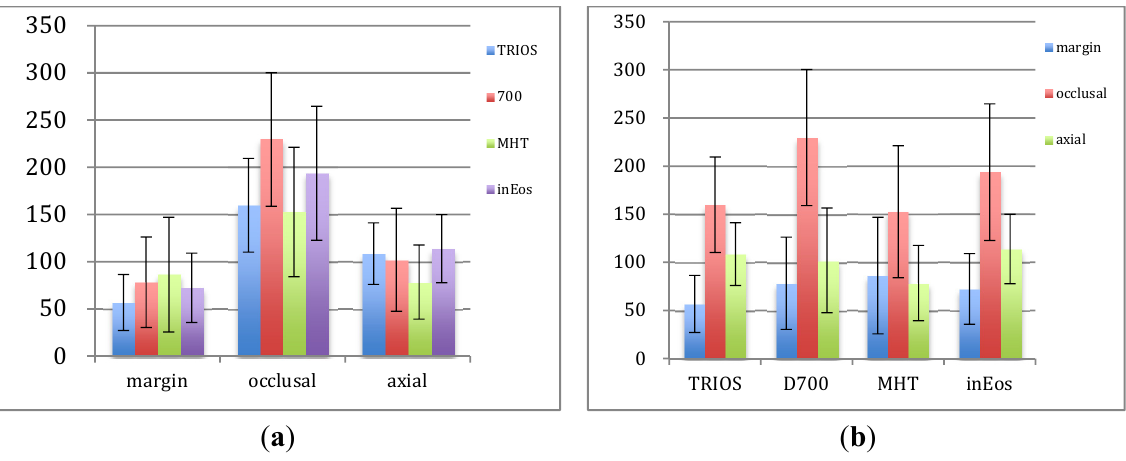
Figure 4. Comparison of the means from each group of marginal, occlusal and axial gaps ( μ m). ( a ) Comparison of different groups for each location; ( b ) Comparison of different locations for each